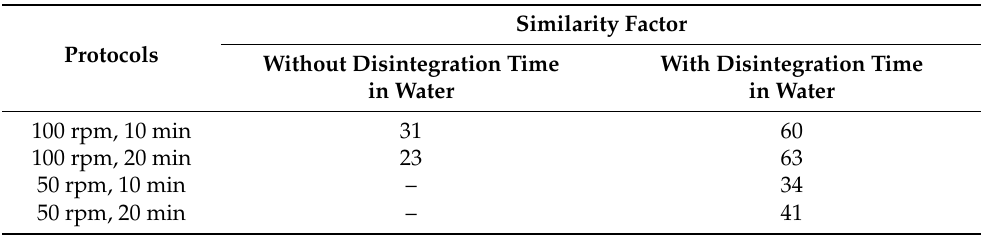
Table 2. Assessment of the similarity in drug permeation profiles between Flivas ® tablets and Flivas ® OD tablets using similarity